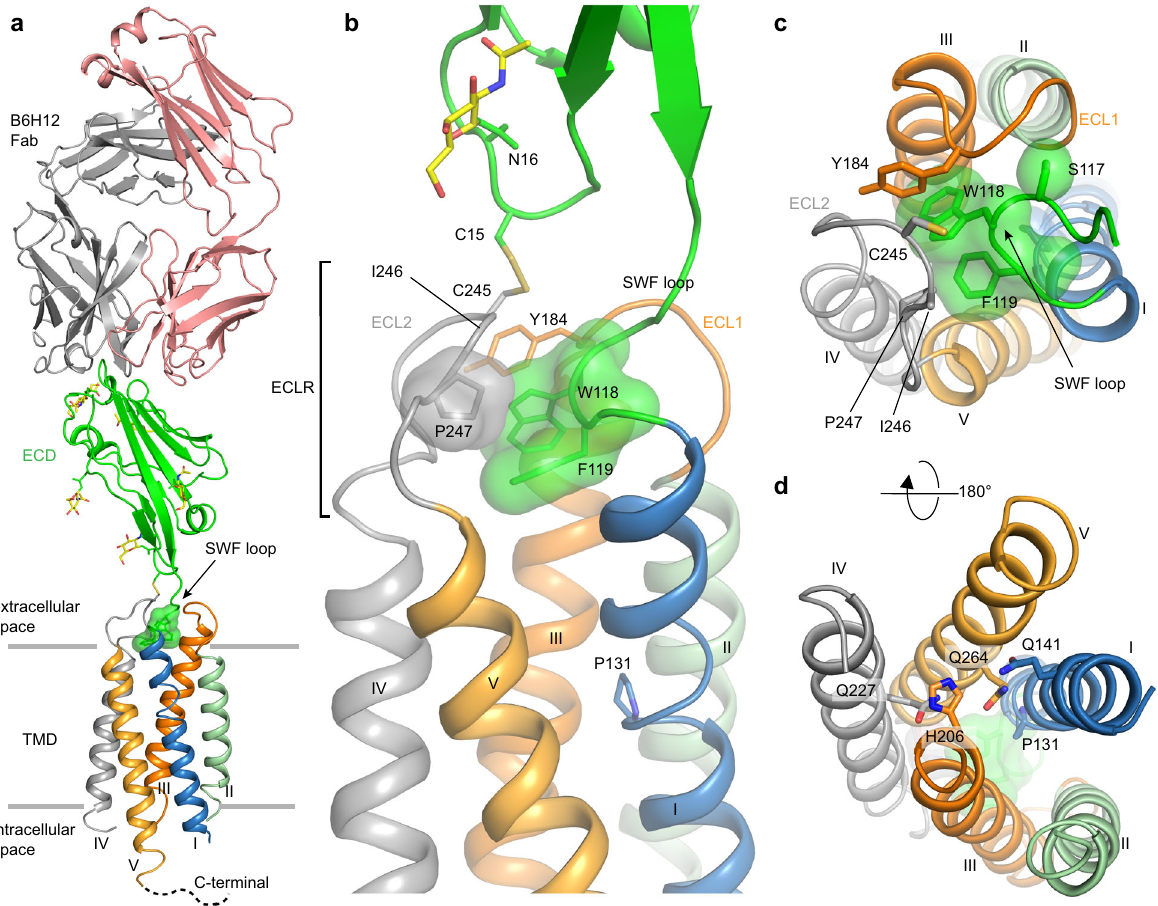
Fig. 1 Overall structure of CD47 BRIL -B6H12 complex, ECLR, and TMD. a CD47 BRIL -B6H12 complex structure showing the Fab (light and heavy chains shown as pink and gray cartoon respectively), the ECD (green cartoon), and the TMD helices (helix I, blue; helix II, light green; helix III, orange; helix IV, gray and helix V light orange). The CD47 ECLR is formed by the ECL1 (orange tube), ECL2 (gray tube), and the 117 SWF 119 loop (green surface shown for W118 and F119). The N-linked glycans are shown as sticks with yellow carbons. The gray lines represent the approximate extracellular and intracellular membrane boundaries. b Close up view of the receptor ECLR showing all the three ECLR loops and important residues (side chains shown as sticks and transparent surfaces). The location of the helical kink in helix I centered on P131 (side chain shown as sticks) is also shown. c Top view of CD47 TMD bundle from the extracellular side showing the position of helices and orientation of the three extracellular loops with respect to the helices. d View of the TM bundle from the intracellular side. The side chain of residues in the IC hydrogen bond network are shown as sticks and